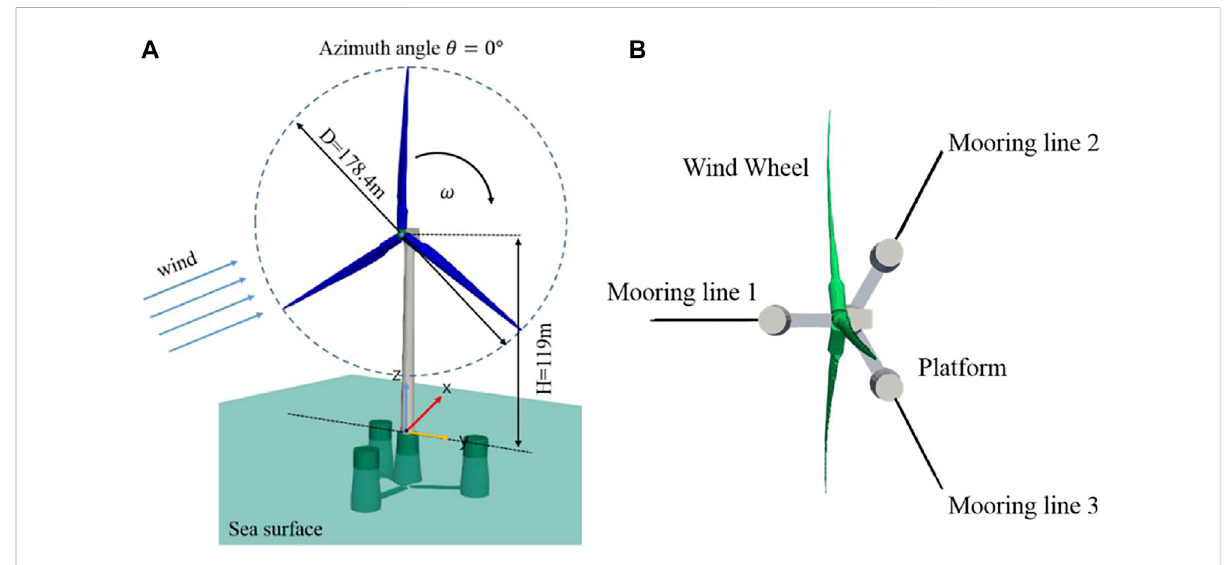
FIGURE 2 Geometry of OO-Star Wind Floater Semi DTU-10MW and mooring system: (A) geometry model; (B) mooring system.